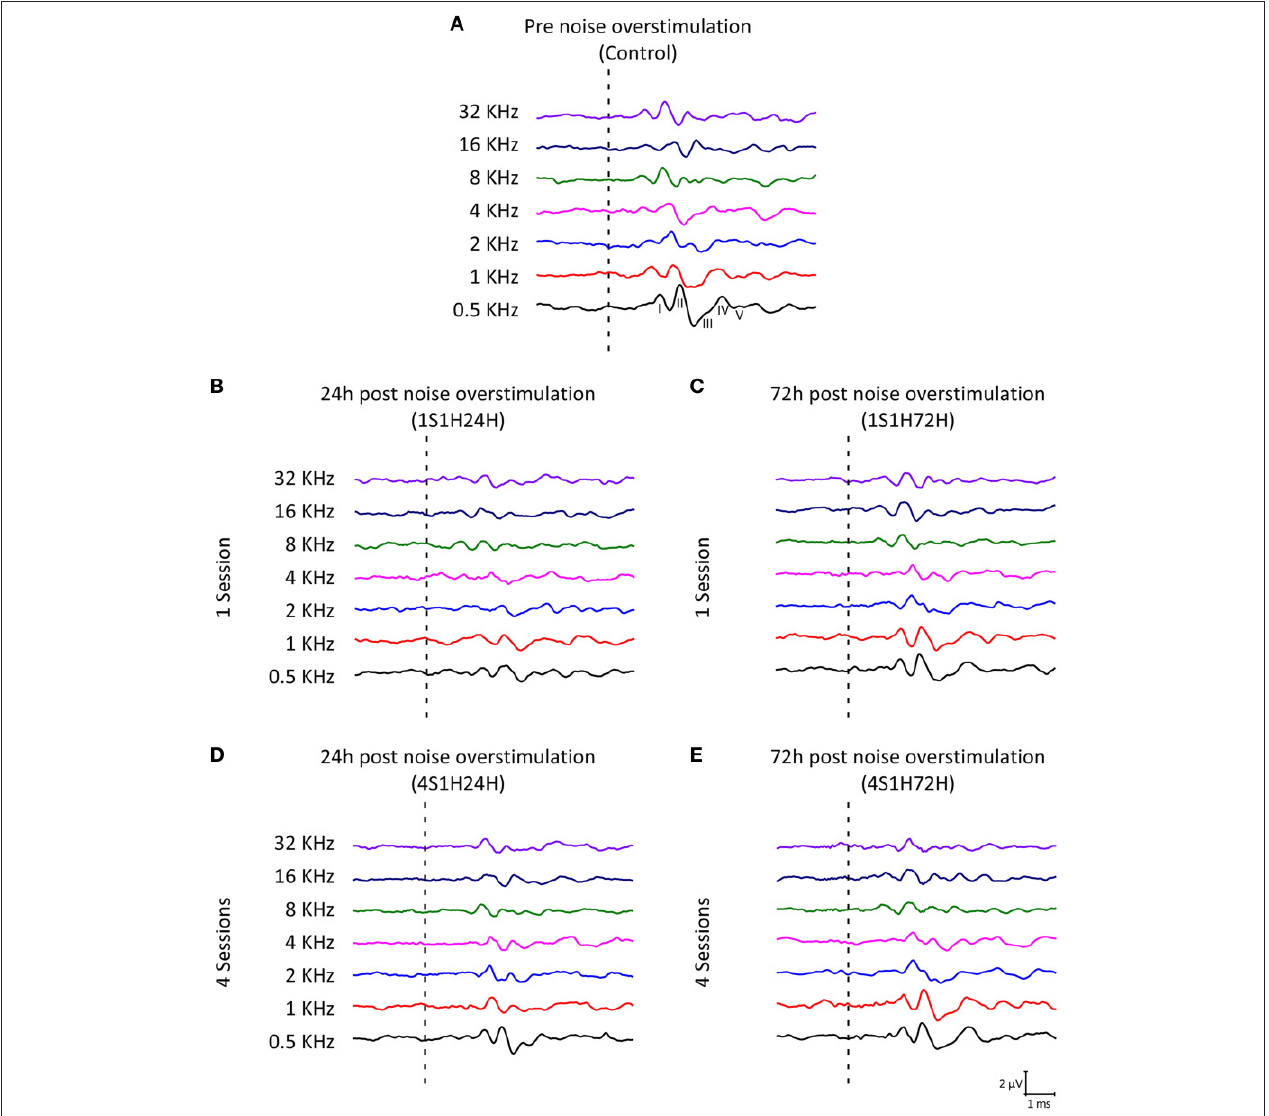
FIGURE 2 | Line graphs showing examples of ABR recordings in control and experimental rats at 80dB SPL for all frequencies evaluated. (A) In the control group, the recordings displayed a distinctive pattern characterized by 4–5 evoked waveforms after the stimulus onset. (B) By 24h after the first session of the noise-induced toughening protocol there was a significant decrease in the amplitude of all waveforms in the ABR. (C) The amplitudes apparently returned to values close to the normal condition in 1S1H72H animals. (D) In 4S1H24H rats, although there was a slightly decrease in the waves amplitude, it was not as evident as